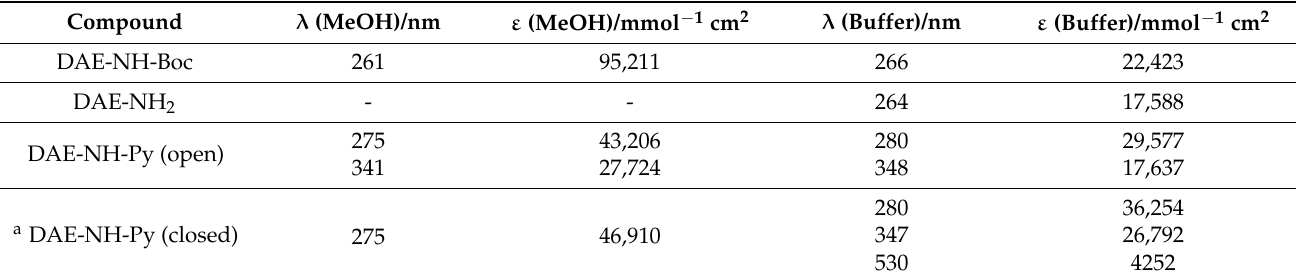
Table 1. Electronic absorption data of DAE-NH-Boc, DAE-NH 2 and DAE-NH-Py (open and closed form).